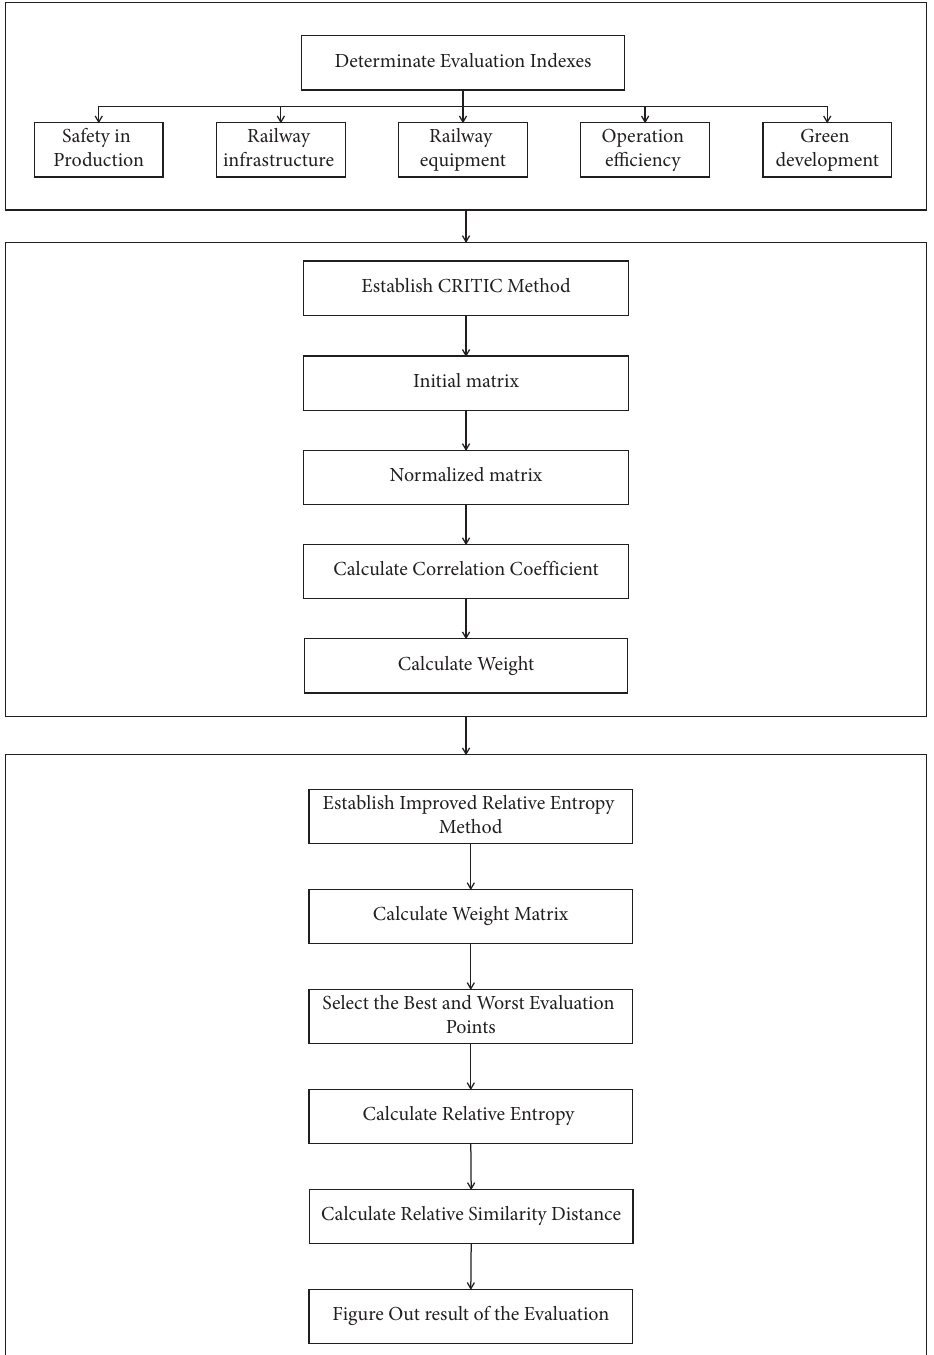
Figure 1: Te steps of the railway transportation performance evaluation